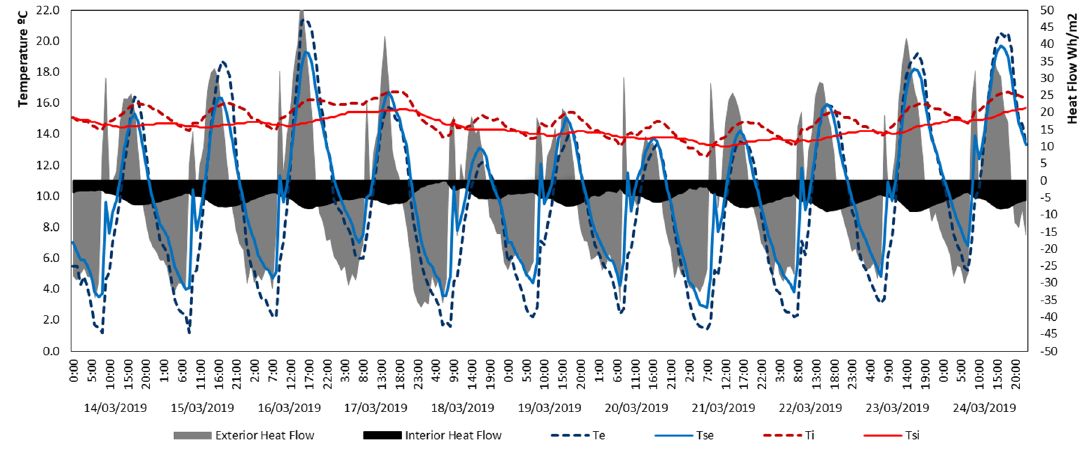
Figure 5. Results of the thermal flow test of the in situ facade .